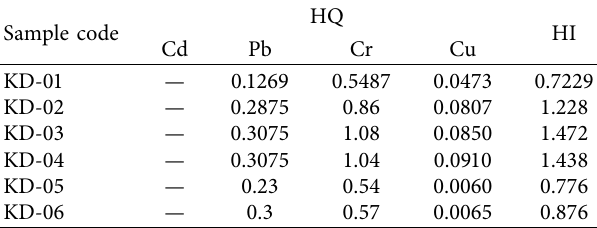
Table 5: HQ and HI values in traditional herbal preparations. Sample